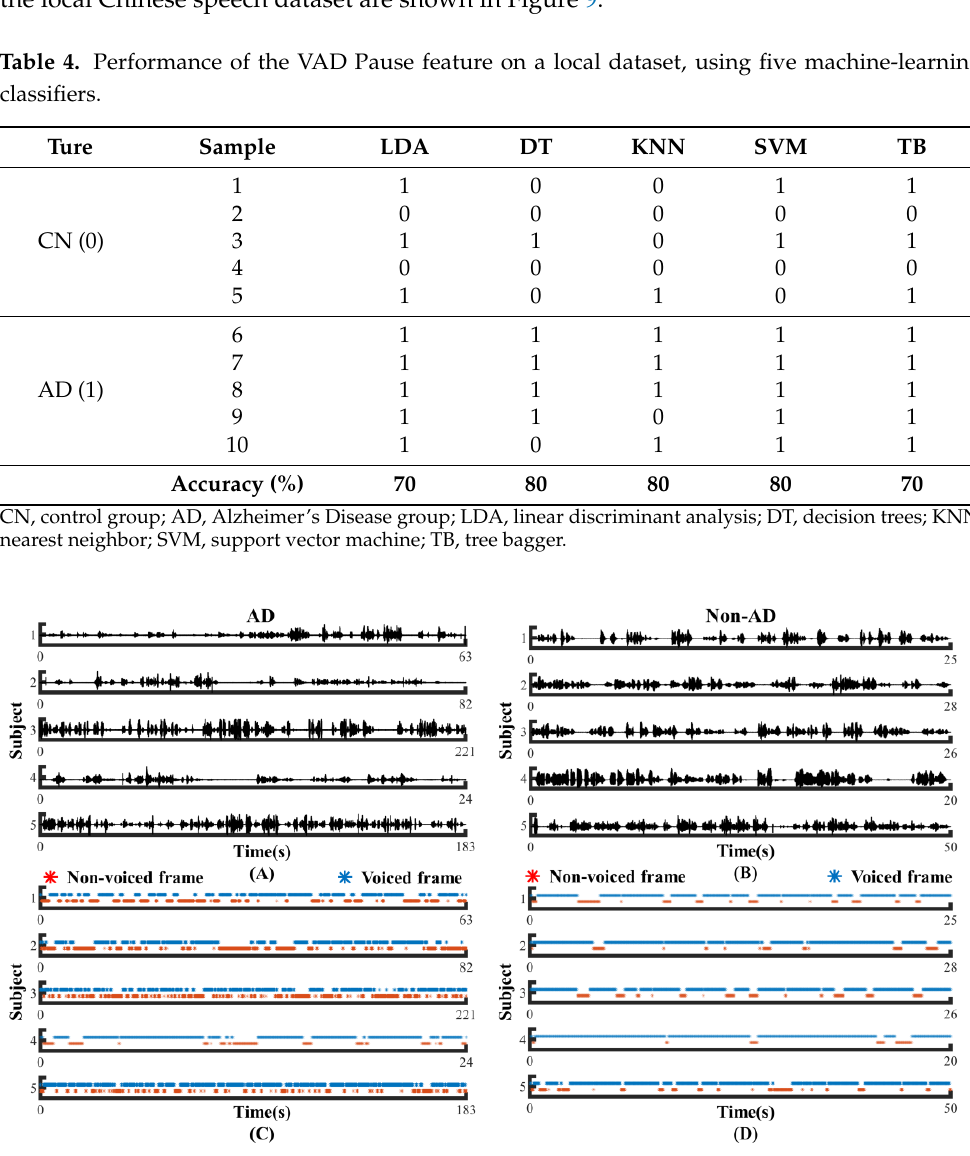
Figure 9. Contrast display of clinical data from AD and non-AD subjects: ( A ) raw audio recordings of AD; ( B ) raw audio recordings of non-AD; ( C ) VAD Pause features of AD; ( D ) VAD Pause features of non-AD. The blue asterisks represent voiced frames, whereas the red asterisks represent non-voiced frames in the figure of pause